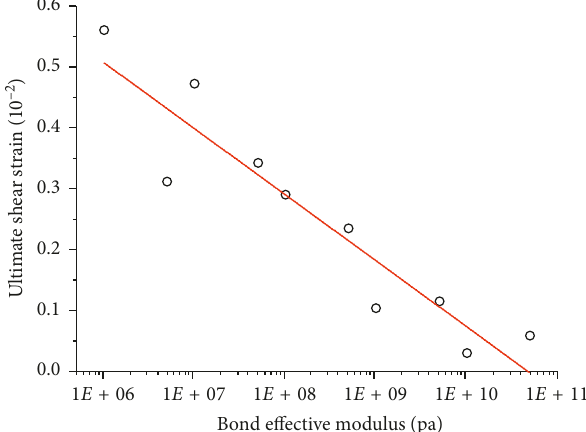
Figure 14: Relationship between ultimate shear strain and ce- mentation degree between